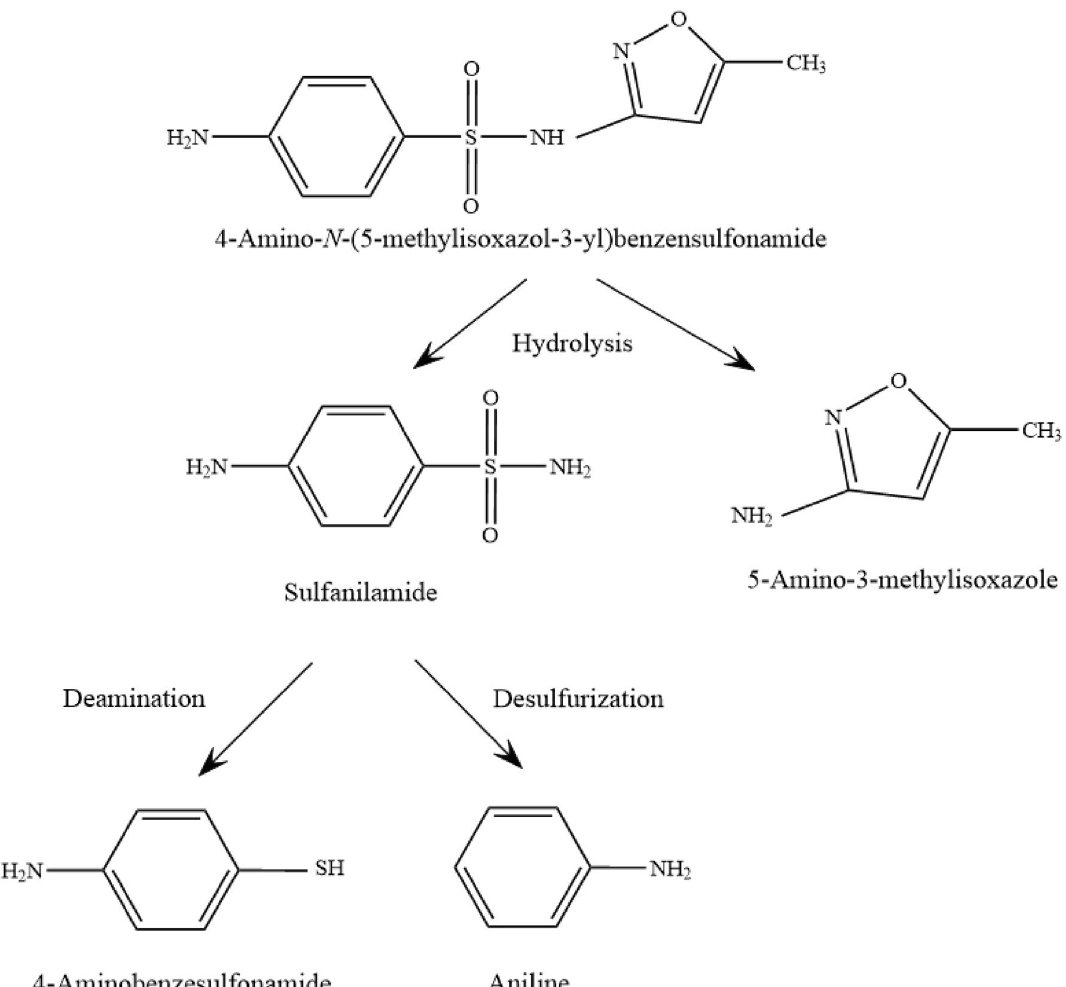
Figure 8. Proposed pathway for the degradation of SMX by S. mizutaii